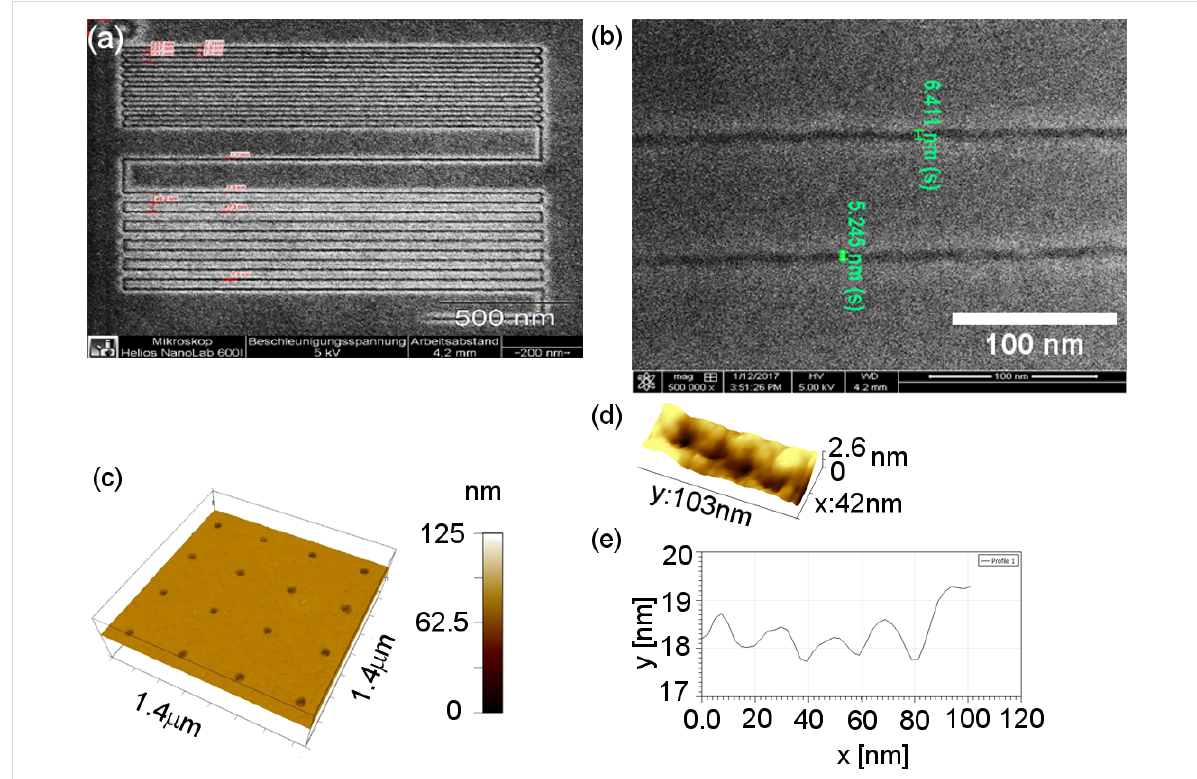
Figure 20: Single-digit nanometre features written by FE-eSPL. (a) SEM image obtained after etching of 9 nm thick AZ ® BARLi ® II resist (AZ Elec- tronic Materials) showing 12.5 nm half pitch structures (upper part), (b) SEM image obtained after etching of 9 nm thick AZ ® BARLi ® II resist